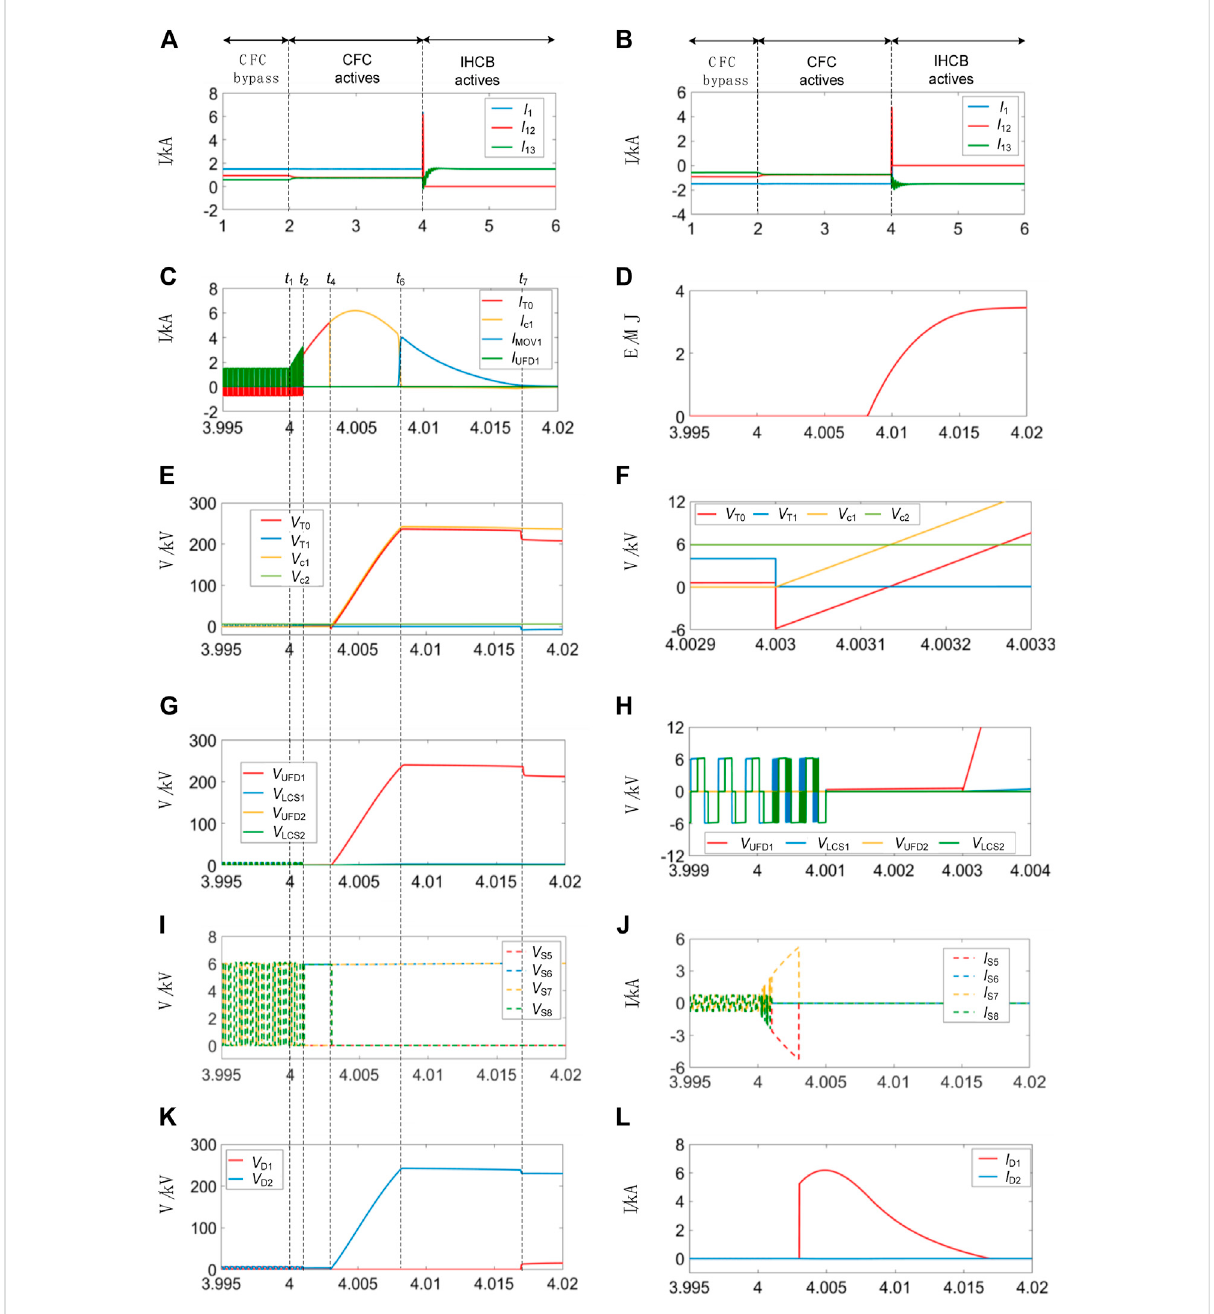
FIGURE 10 Performance of SCR-IHCB. (A) Current waveforms with forward power fl ow. (B) Reverse power fl ow. (C) Fault current transfer process. (D) Energy absorb by